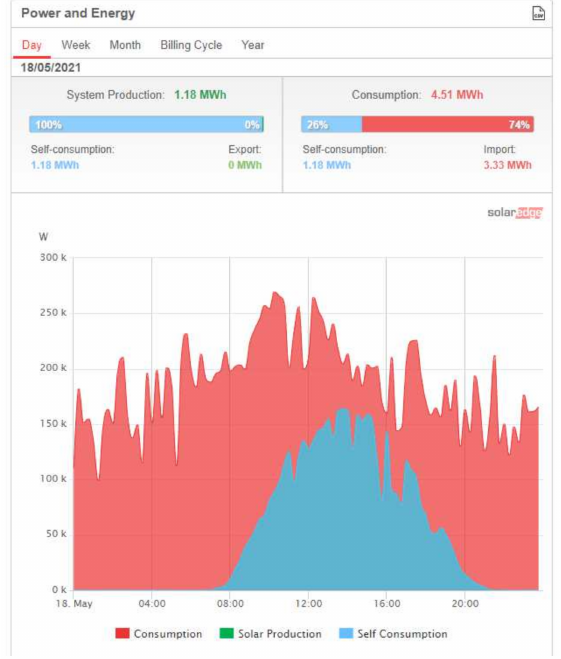
Figure 12. Screenshot of the monitoring portal showing the electricity consumption and production on one spring day (18 May 2021). The figure shows the 15-min average power in Watts for the consumption and PV production.